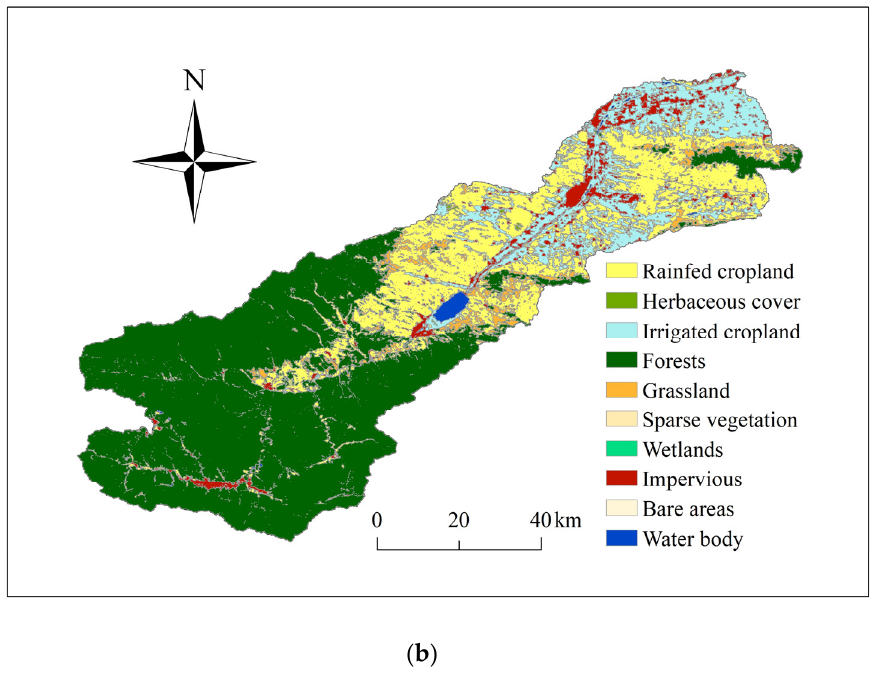
Figure 3. ( a ) Land cover of the Yi River basin in 2015; ( b ) Land cover of the Yi River basin in 2020. Table 1. Land cover area (km 2 ) transfer matrix in the Yi River basin.